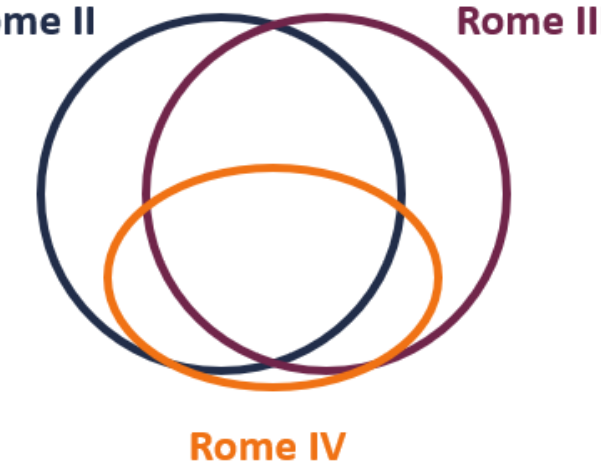
Figure 2. Venn diagram for range and relationship between IBS diagnostic criteria Rome II, III and IV